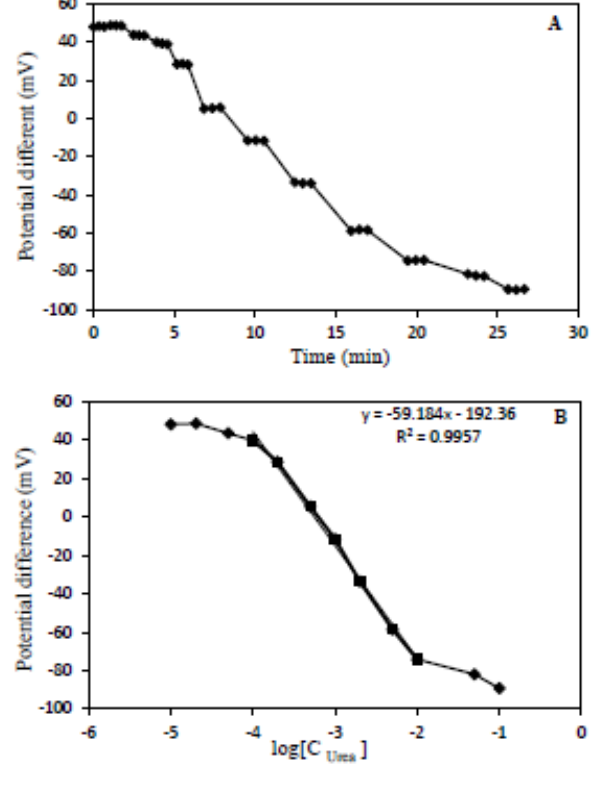
Figure 8. Response time of the urea potentiometric biosensor when the concentrations of urea were changed step by step from 10 −5 M–10 −1 M ( A ); The observed potential in (A) was plotted against urea concentrations from 10 −5 M–10 −1 M ( B